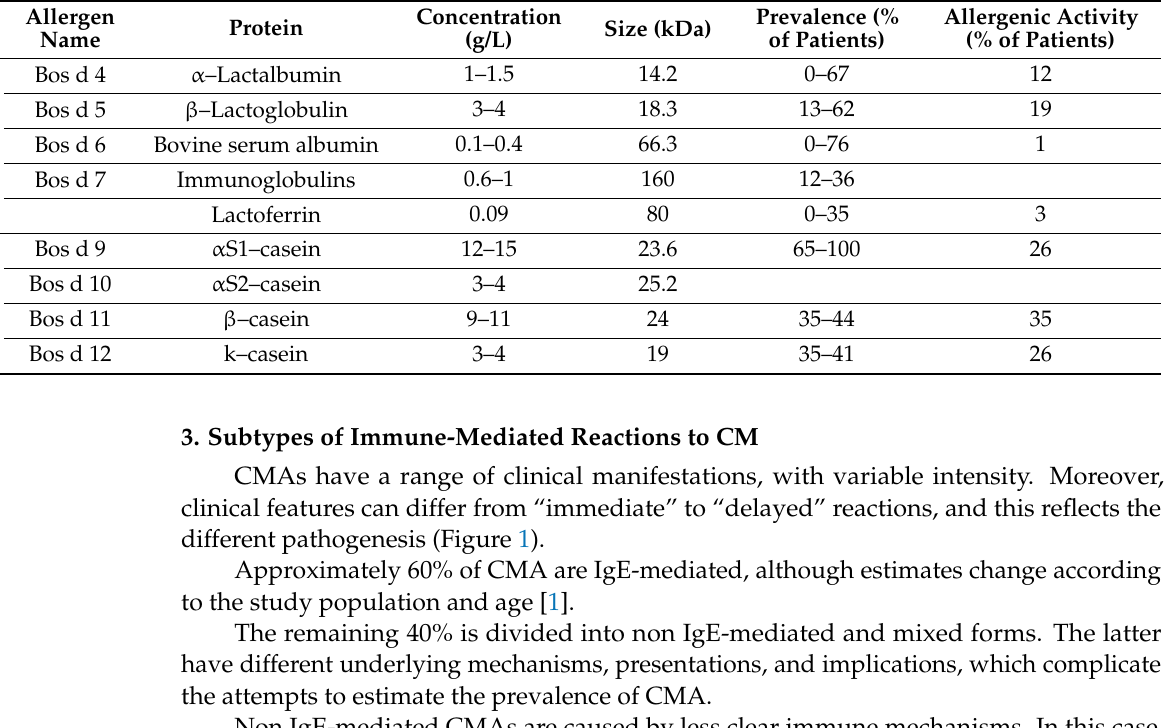
Table 1. Main characteristics of CM allergens, adapted from Hochwallner